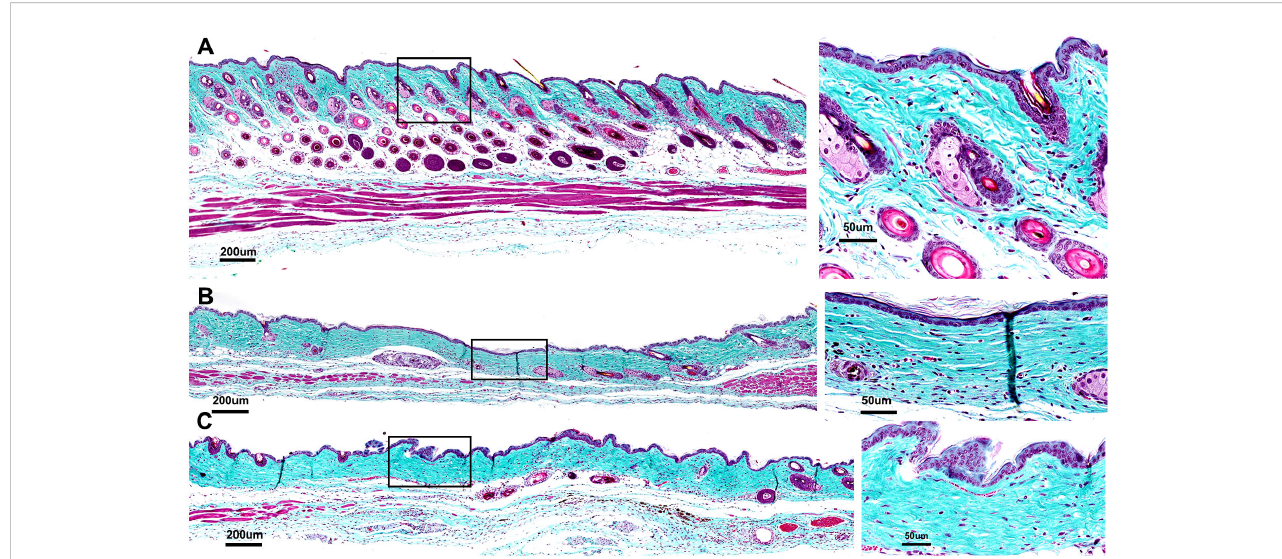
FIGURE 7 Histological sections of skin regions where the tumor had been treated stained with Gomori ’ s trichrome to assess collagen linearization and compaction (inset 4X greater magni fi cation of black box region marked on the left). (A) Section showing no damage in which collagen and muscle are structurally intact with no loss of hair follicles; (B) Mild-moderate damage indicated by slight linearization and compaction of collagen indicating dermal fi brosis and loss of hair follicles; (C) Moderate-Marked damage indicated by moderate linearization and compaction of dermal collagen, clear loss of hair follicles and signi fi cant muscle atrophy across entire treatment